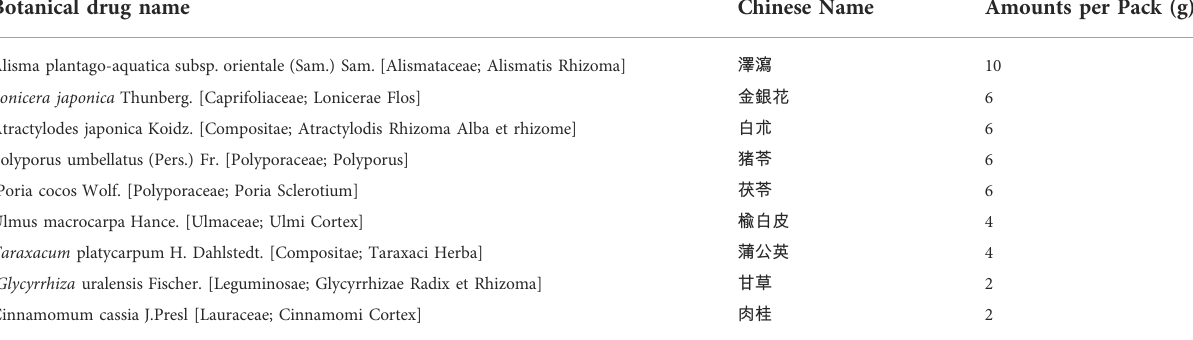
TABLE 1 Composition and dose of one pack of Chung-Pung Decoction (1pack 120